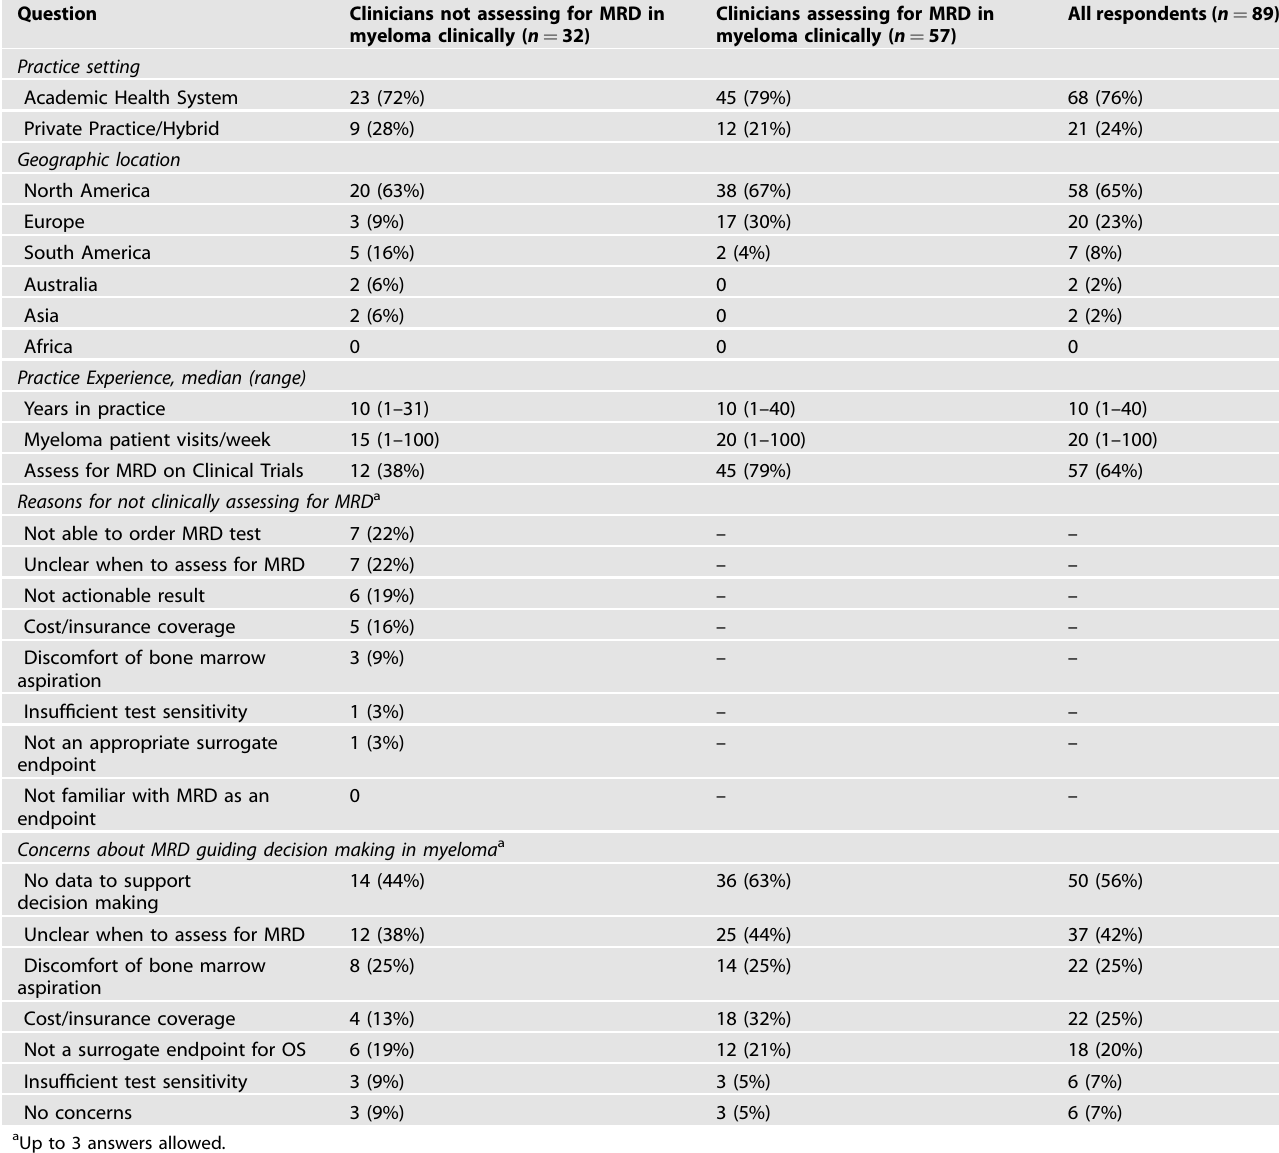
Table 1. Demographics and attitudes toward MRD in multiple myeloma.